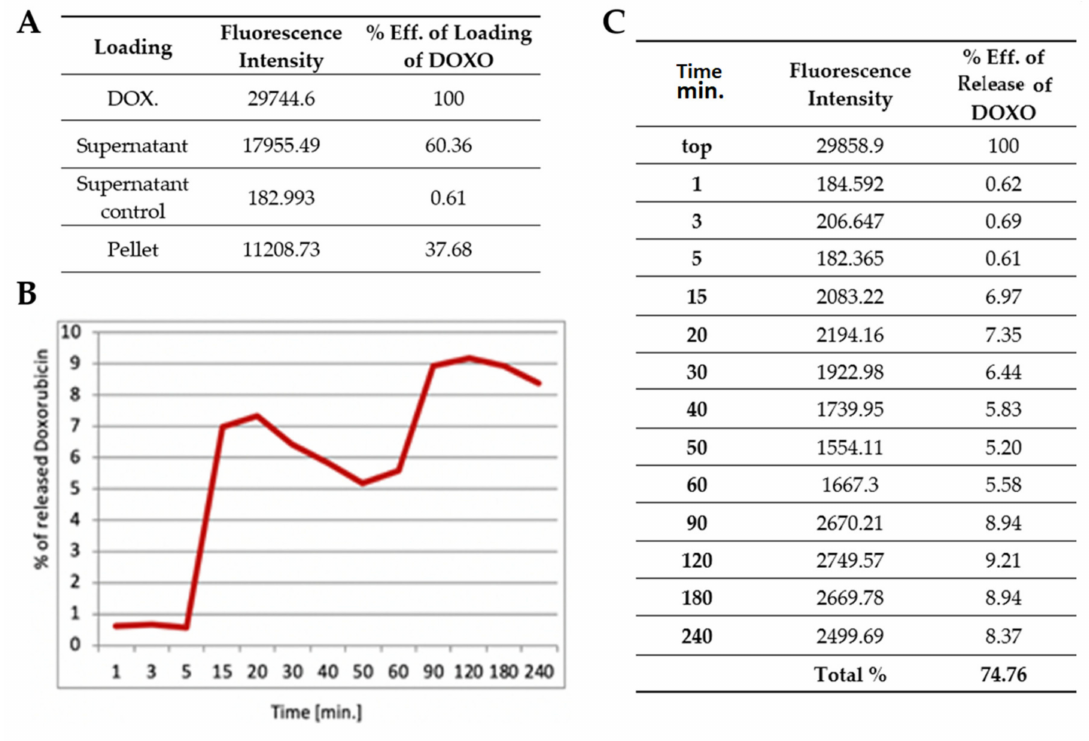
Figure 5. ( A ) Quantification of cargo loading. ( B ) Release kinetics for doxorubicin in first 240 min. ( C ) Quantification of cargo release at the appropriate time points.